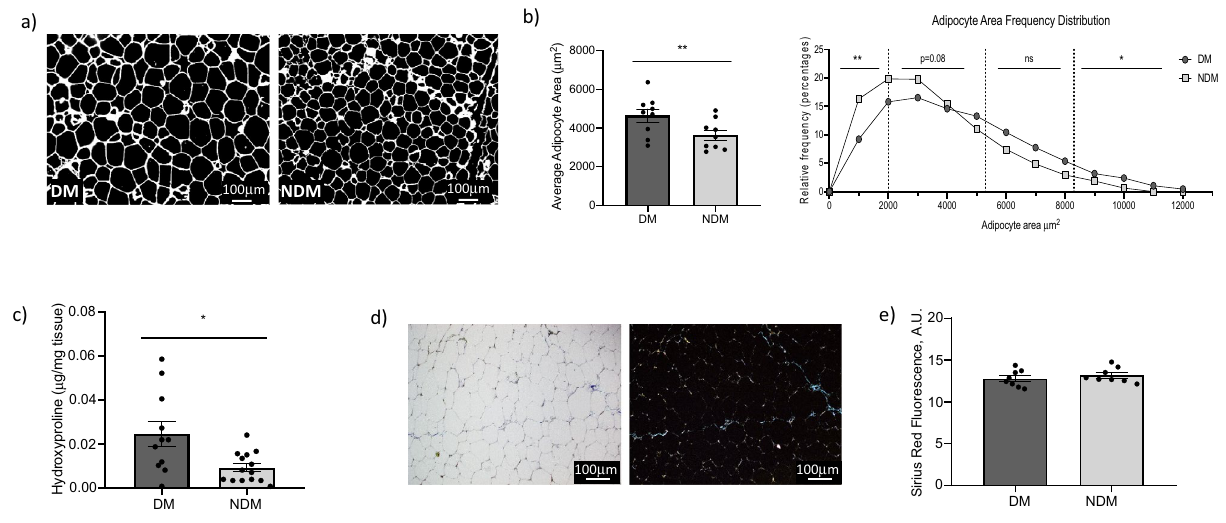
Figure 4. ( a ) Representative fluorescence images of sectioned VAT (scale bars: 100 µm) used for quantifying adipocyte area; ( b ) average adipocyte area (µm 2 ) displayed as bar graphs (left, ** p = 0.004 comparing DM and NDM average adipocyte area, controlling for age and BMI; error bars display standard error of mean), and adipocyte area frequency as histograms (right, p = 0.003 (**), 0.08, 0.184 (ns), 0.013 (*) respectively for each sizing group comparing DM and NDM adipocyte area frequency and controlling for age and BMI, generalized linear mixed model with negative binomial distribution); ( c ) hydroxyproline content in VAT: ordinate; hydroxyproline (µg/mg tissue); * p = 0.022 comparing DM and NDM groups, independent t-test; error bars display standard error of mean; ( d ) representative standard light microscopy (left) and polarized light (right) images of sectioned, Sirius Red-stained human VAT (scale bars: 100 µm); ( e ) quantified Sirius Red staining in VAT comparing DM and NDM groups; p = 0.437 comparing DM and NDM groups, independent t-test; error bars display standard error of